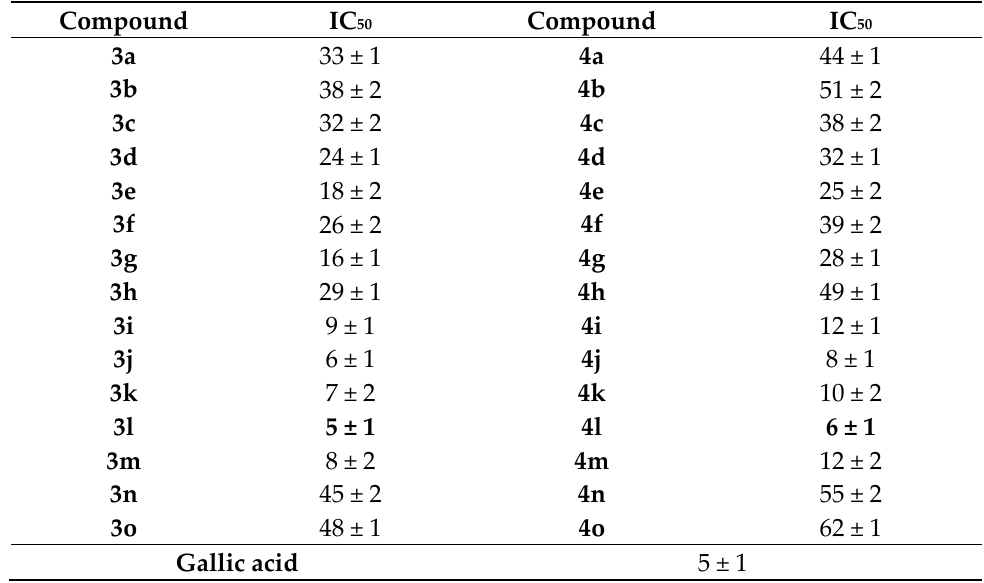
Table 3. Comparison of the DPPH assay results of chalcones and pyrazolines (IC 50 values in µg/mL).